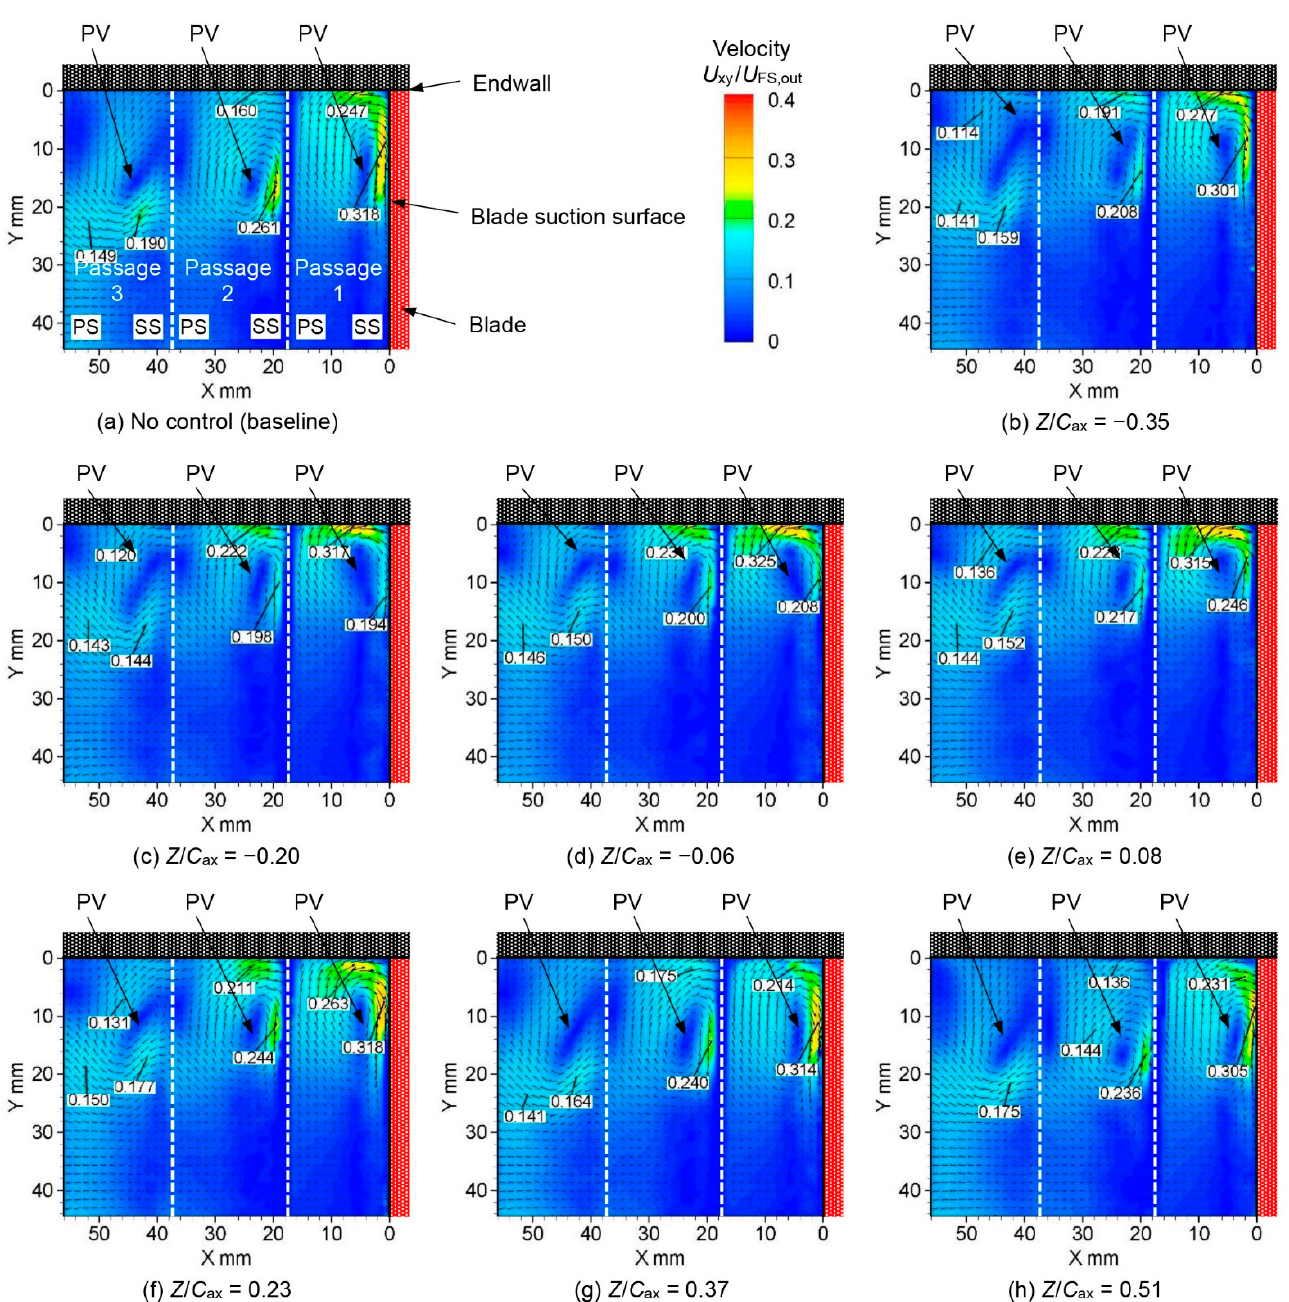
Figure 17. Velocity distributions of secondary flow at the outlet of the linear turbine cascade at var- ious plasma actuator locations (Re out = 3.7 × 10 4